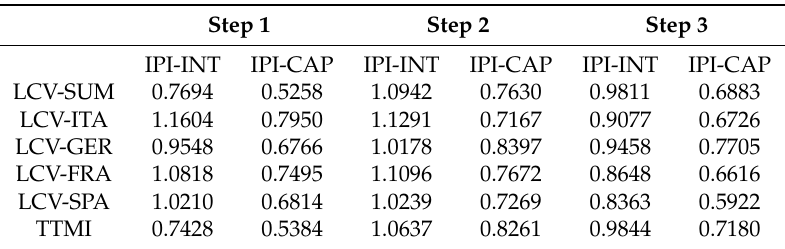
Table A23. Comparison of mean absolute error with expanding window applied to conditional var with three variables. The forecast windows expands itself from 2015:01 to 2018:12. The ratio between MAEs is shown. A value less than one shows an improvement over benchmark.